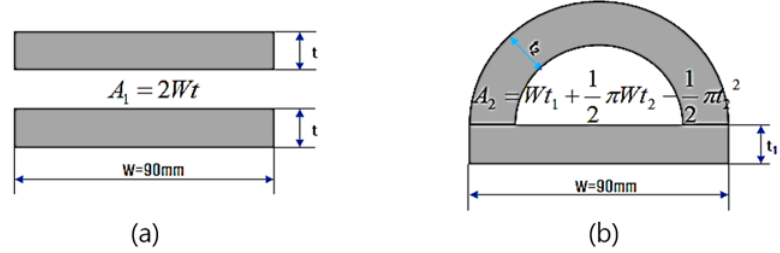
Figure 1. Schematics of cross-sections of bus-bar; ( a ) Plate-type, ( b ) Tunnel-type.